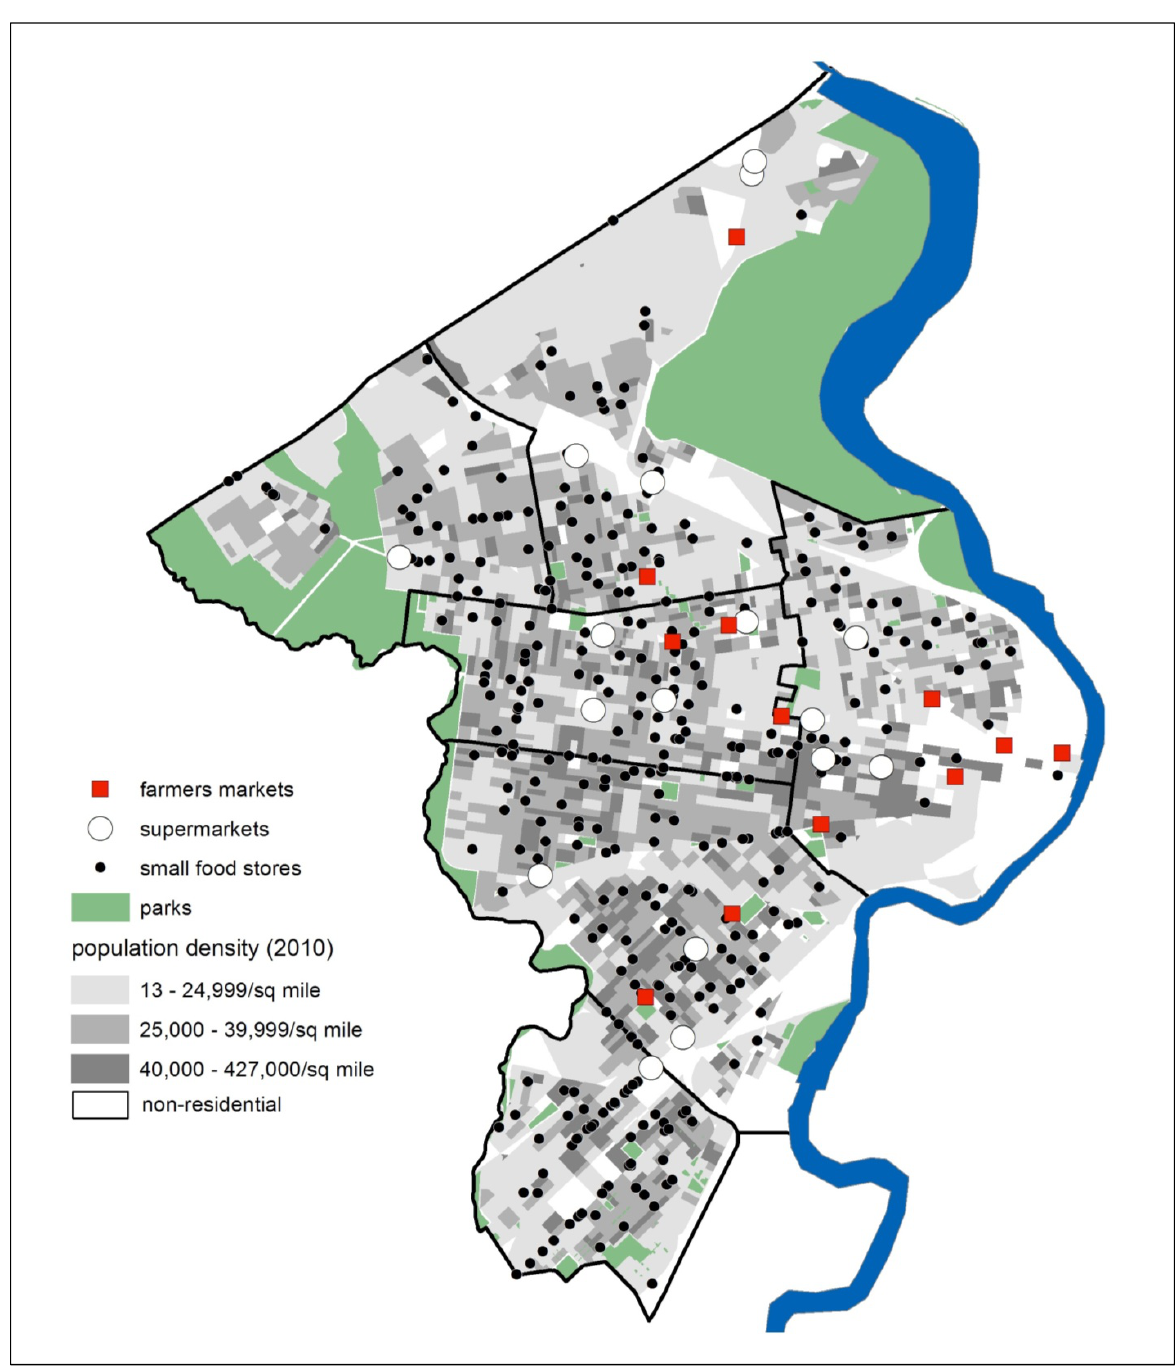
Figure 1. Food Retail Landscape, West and Southwest Philadelphia,